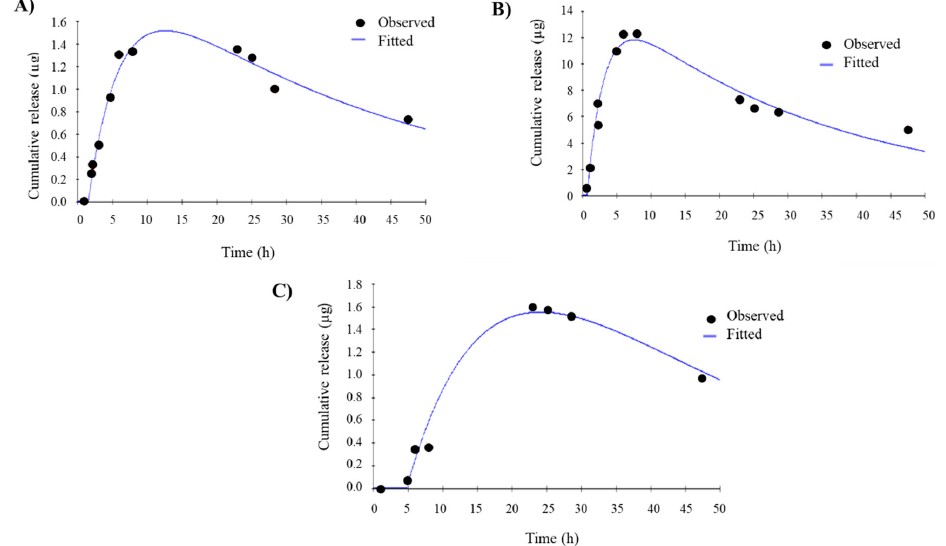
Figure 2. In vitro release profile, measured mass of released peptide (black circles) fitted to a mono-compartmental model (blue lines). ( A ) Mono-compartmental fitted model of free E1P47; ( B ) Mono-compartmental fitted model of PLGA (E1P47) NPs; ( C ) Mono-compartmental fitted model of POPC (E1P47) LUVs.